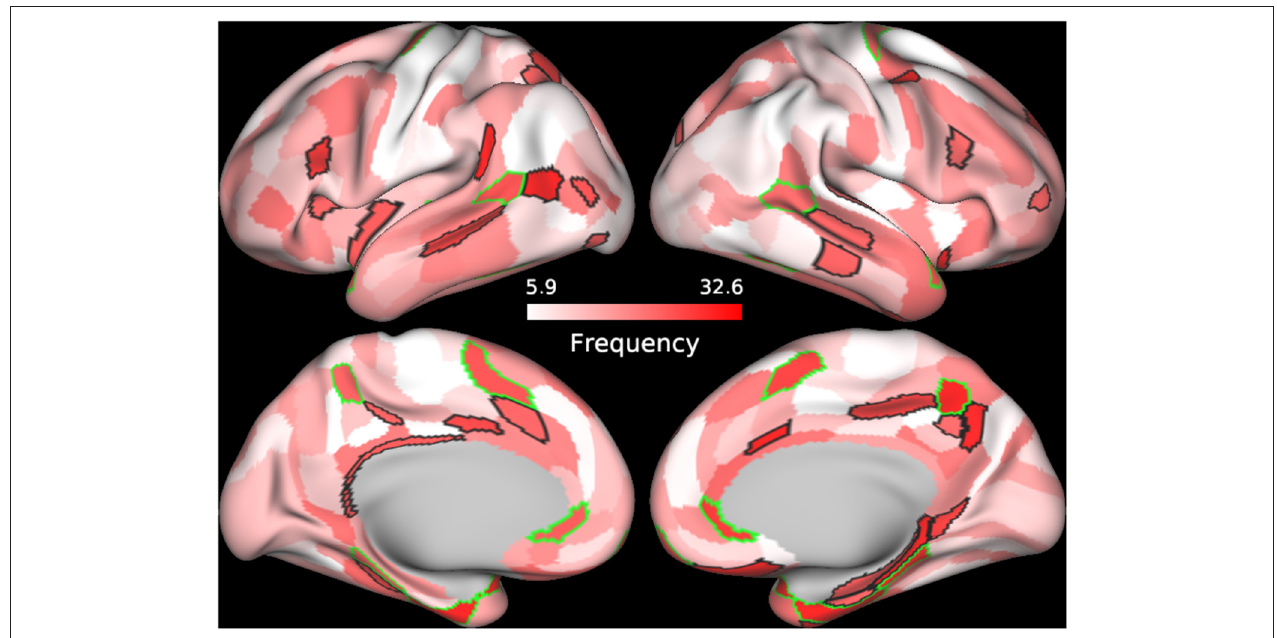
FIGURE 2 | Frequently selected features. The frequency of selection for each cortical feature used to train the SVM model using BC + CC + DC and proposed Enet-subset feature selection method was plotted onto a cortical mesh surface. The top 60 features were selected in all 100 iterations and sorted according to the frequency of its selection during the 100 iterations. Cortical regions outlined in green are bilateral while those outlined in black are